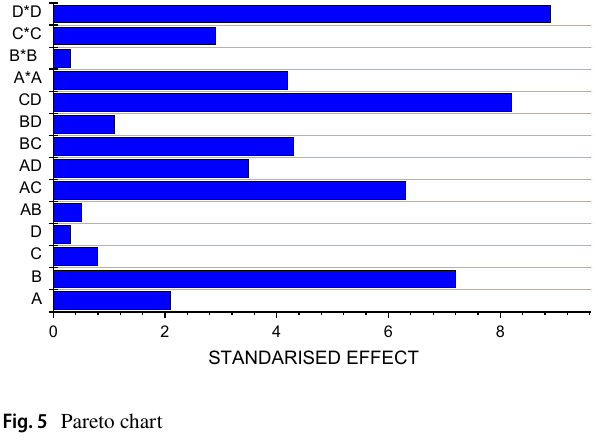
Fig. 5 Pareto chart Table 4 Summary of parameters for various isotherm models for adsorption of carbaryl onto EGP